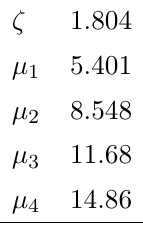
= 3 : 1 ( (cid:21) = 0 : 98), obtained sing